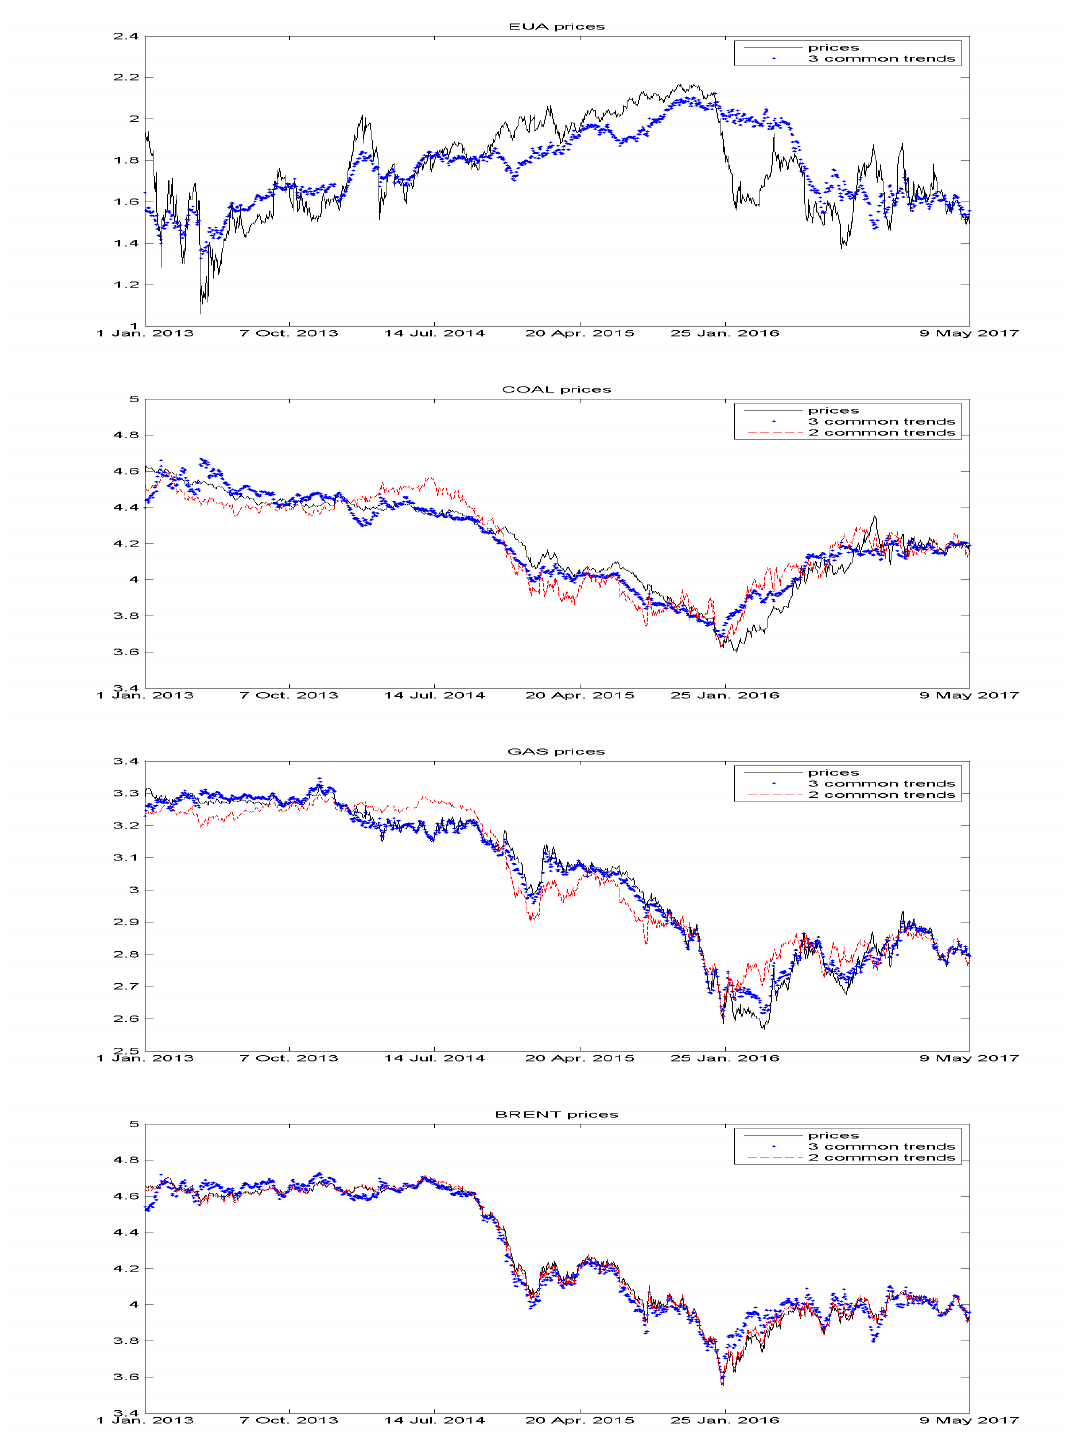
Figure 4. Permanent component A 1 f t in the decomposition (5) using the three and two common trends obtained from daily data on Y t and (cid:101) Y t , respectively. The sample spans the period January 2013–May